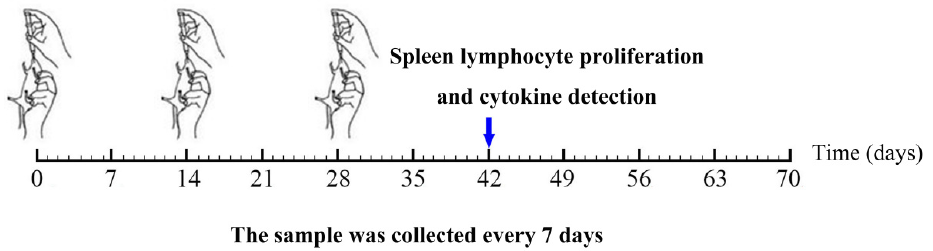
Figure 2. The timeline of mice immunization procedure and sample collection. Mice ( n = 90) were equally divided into three groups. The black font represents the days of immunization; a sample was collected every seven days. Spleen lymphocyte proliferation assay and cytokine detection were performed on day 42.